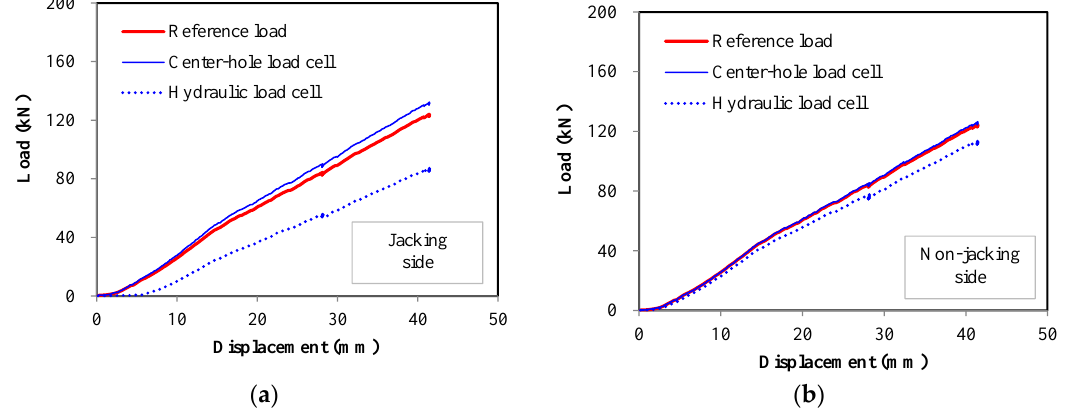
Figure 4. Test results of one tendon in the steel frame. ( a ) Jacking side; ( b ) Non-jacking side.